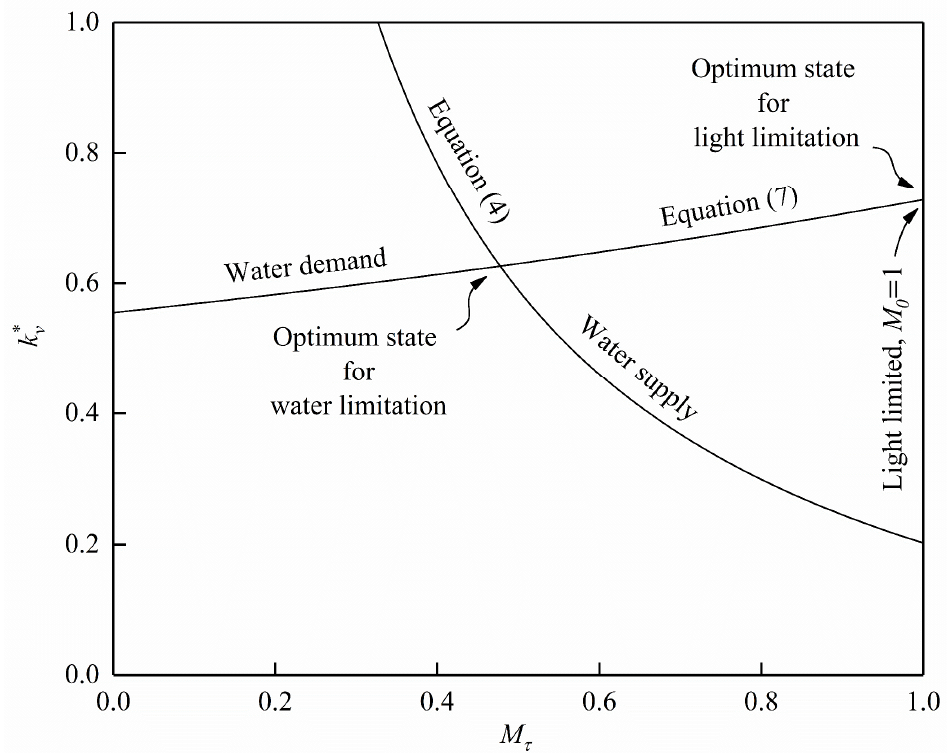
Figure 2. Optimum canopy state, where M τ is the mean vegetation coverage during growing season, dimensionless; and k ∗ v is the potential canopy conductance, dimensionless